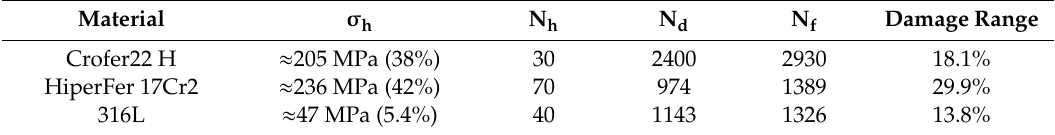
Table 6. Strengthening during thermomechanical fatigue (TMF) loading ( σ h ), hardening cycles (N h ), damage initiation (N d ), technical TMF lifetime (N f ), and damage ranges (i.e., relation of N f and N d ;